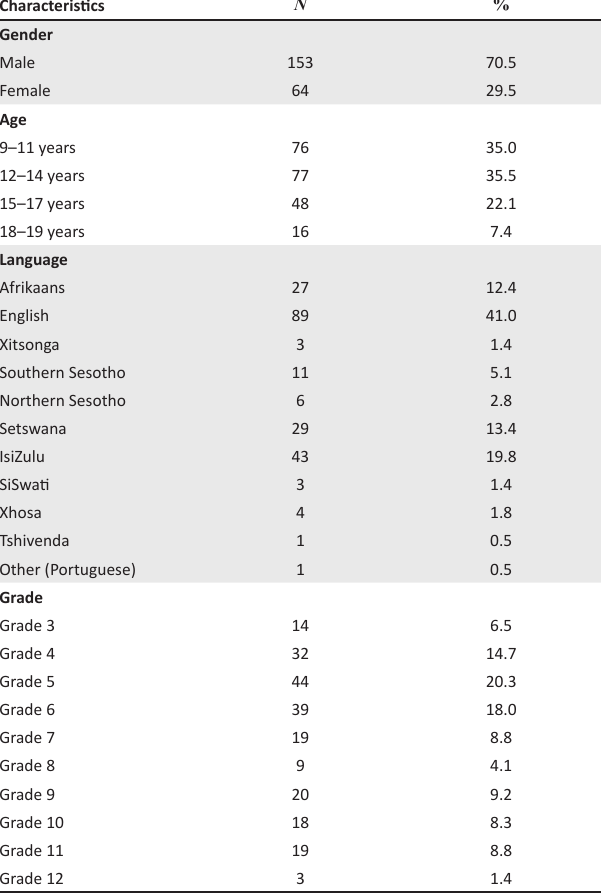
TABLE 1: Demographic characteristics.